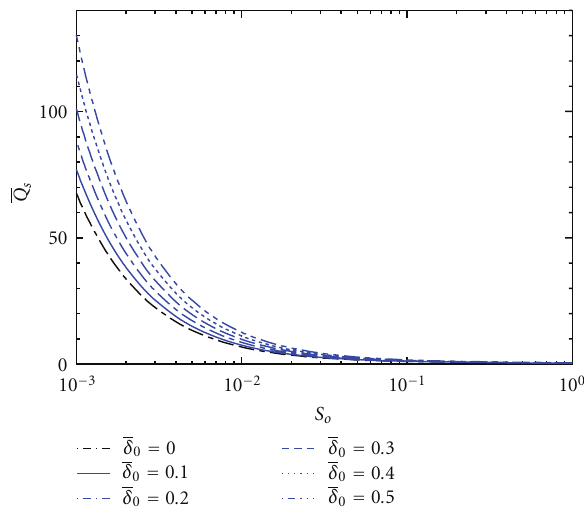
Figure 5: E ff ect of dent δ o on side leakage flow rate Q